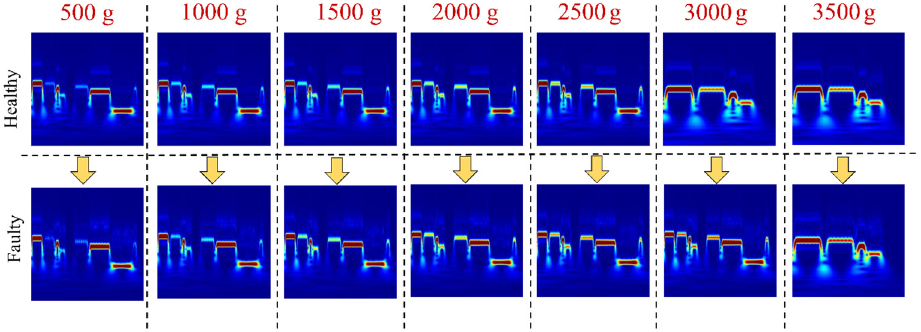
Figure 11. Scalogram representation for various loading conditions for healthy and faulty state under the same operating conditions of 10% speed.